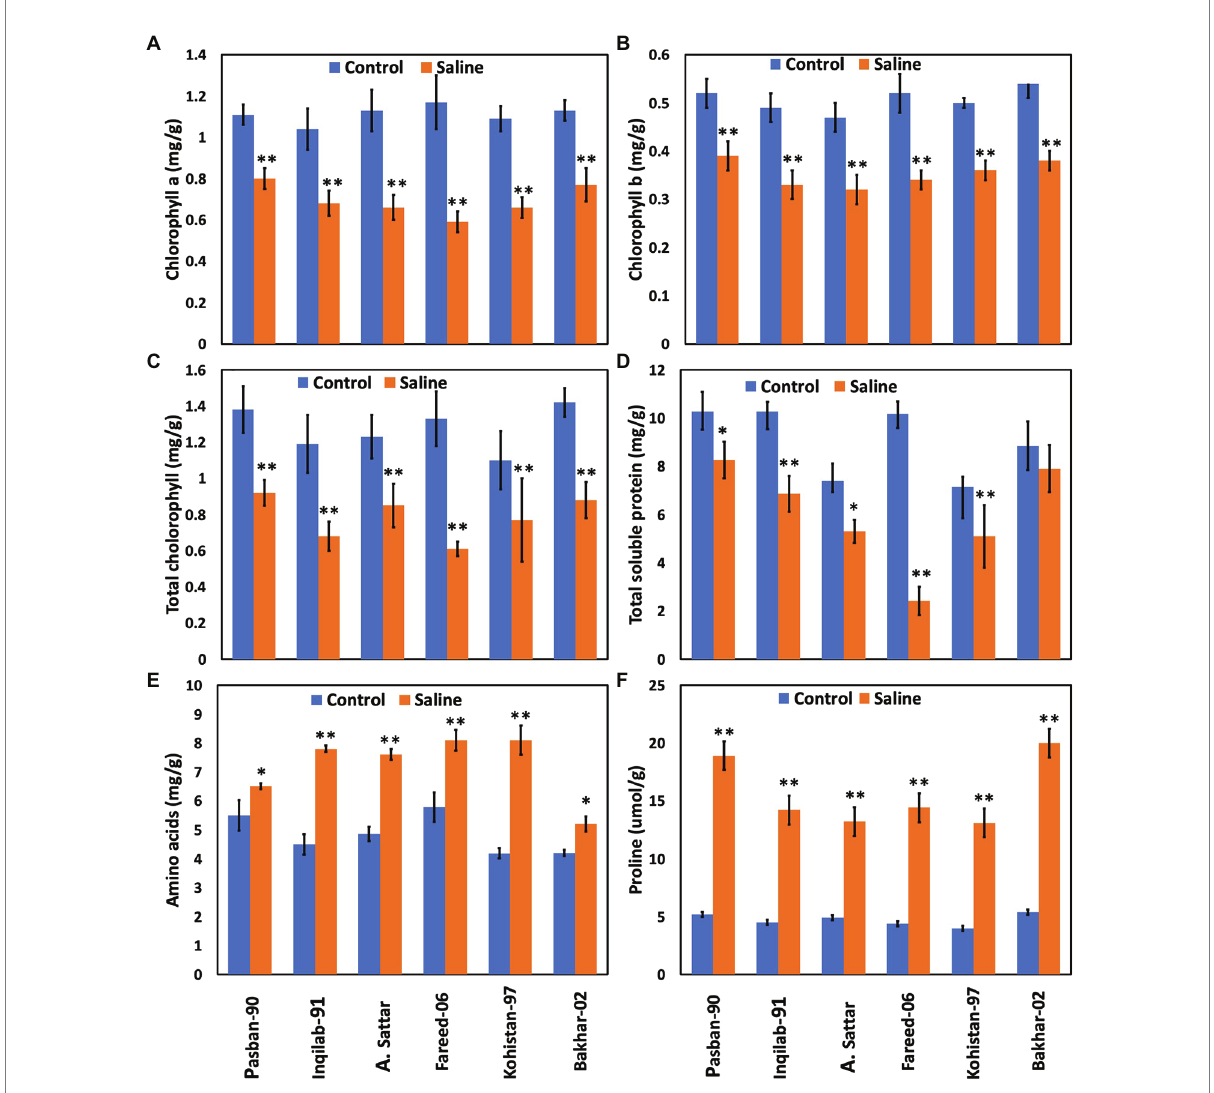
FIGURE 4 Physiological attributes of six wheat varieties under salt stress (150 mM) and control condition (0 mM). (A) Chlorophyll a, (B) chlorophyll b, (C) total Chlorophyll, (D) total soluble protein, (E) total free amino acids, (F) proline. Bars indicate ±. Mean values are indicated on the vertical axis. Asterisks (**) indicate that the trait mean was significantly different (value of p < 0.01) between the salt and control